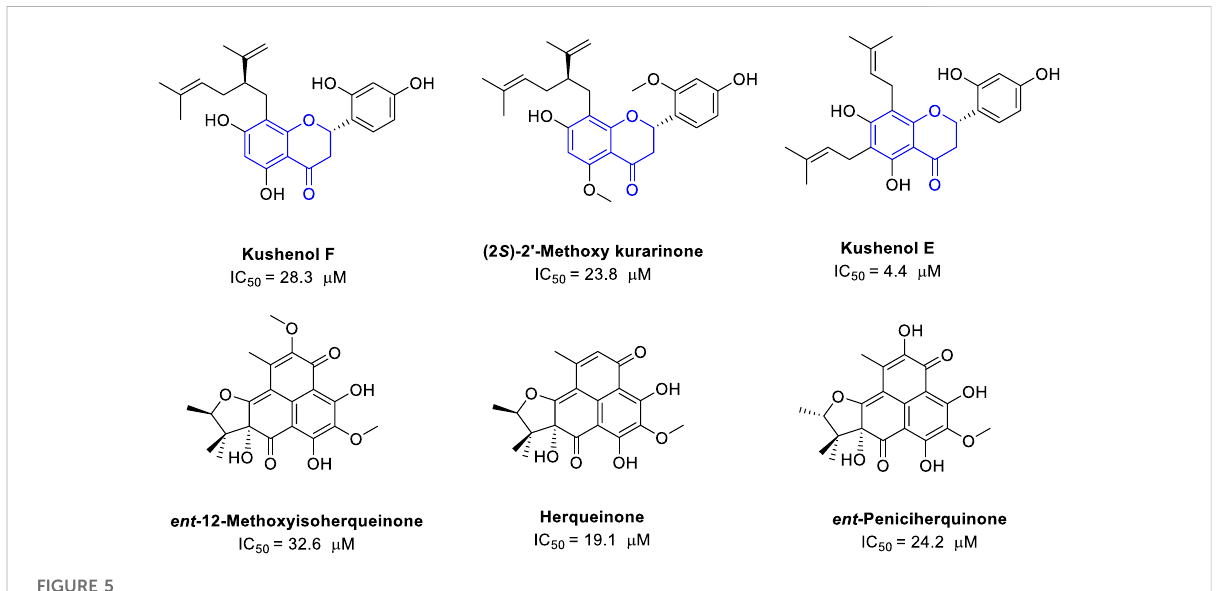
FIGURE 5 Structures of natural polyphenols with their IDO1 inhibitory